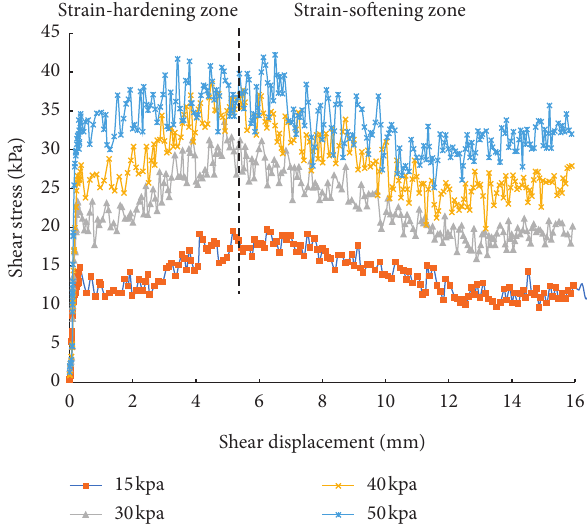
Figure 8: Shear stress-shear displacement curve of 0.6cm vertical kraft paper-reinforced